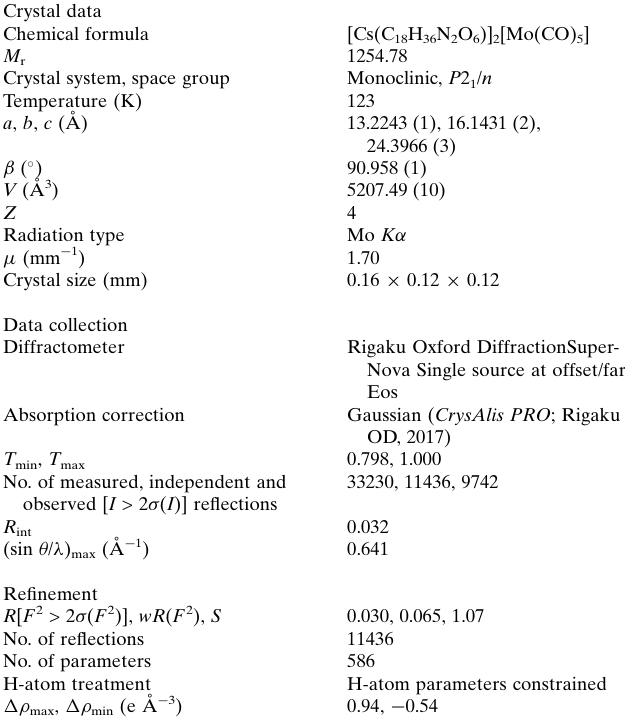
Table 1 Experimental details. Crystal data Chemical